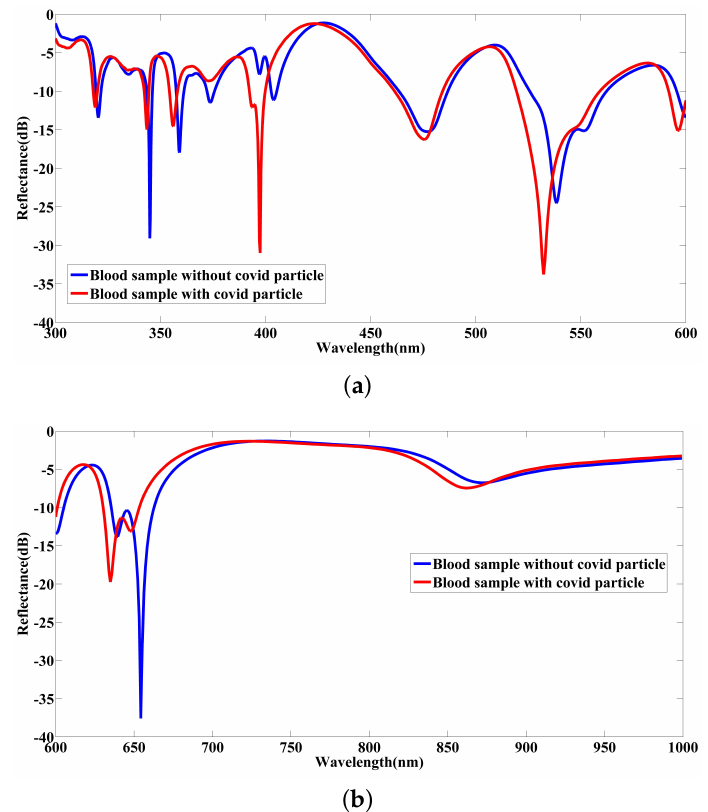
Figure 11. The simulated reflectance spectra arising from the proposed nanosensor when testing blood samples without COVID-19 particle and with a single COVID-19 particle for wavelengths interchanged between ( a ) 300 − 600nm and ( b ) 600 −